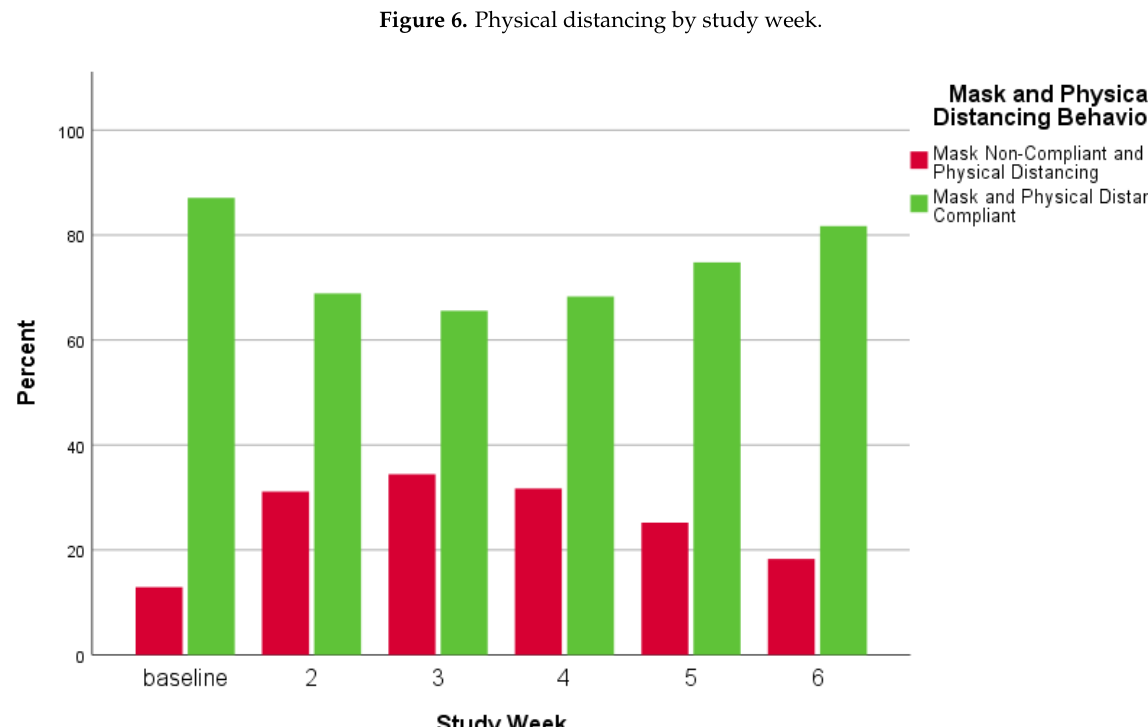
Figure 7. Mask and physical distancing behaviors combined by study week. Table 7. COVID-19 transmission behaviors by specific place of observation.